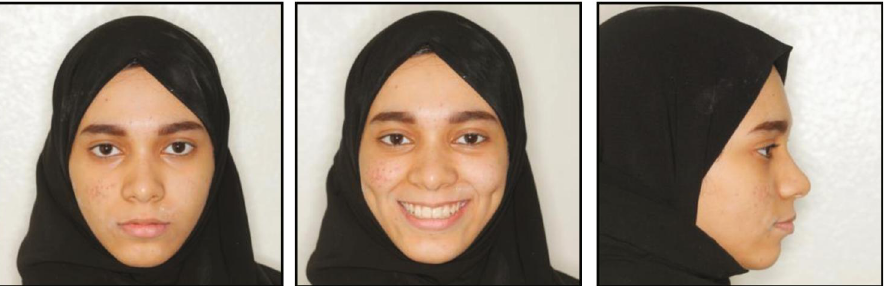
Figure 14: Posttreatment facial photographs.